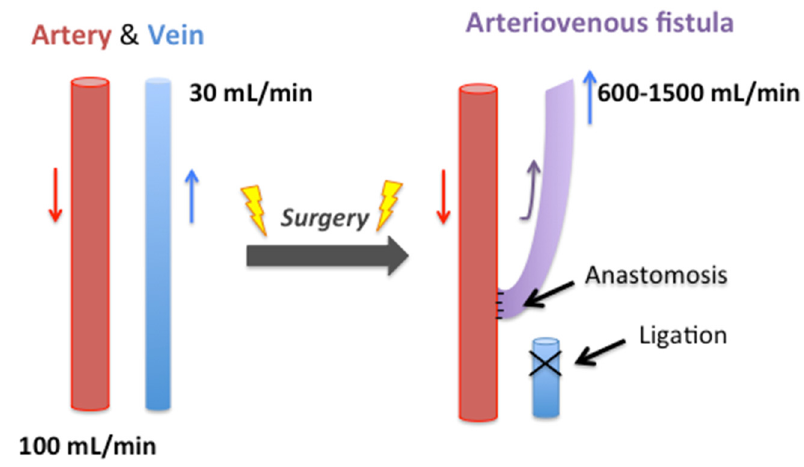
Figure 1. A fistula is direct communication between a vein and an artery, frequently on the upper limb of the patient. This communication is made by the surgeon with the help of a suture. The vein is dissected and ligated its extremity, and sewn to the artery. The arterial blood (red arrow) flows into the vein (blue arrow) through this anastomosis. The fistula matures, and the blood flow in the fistula (purple arrow) reaches around 1 L per minute.